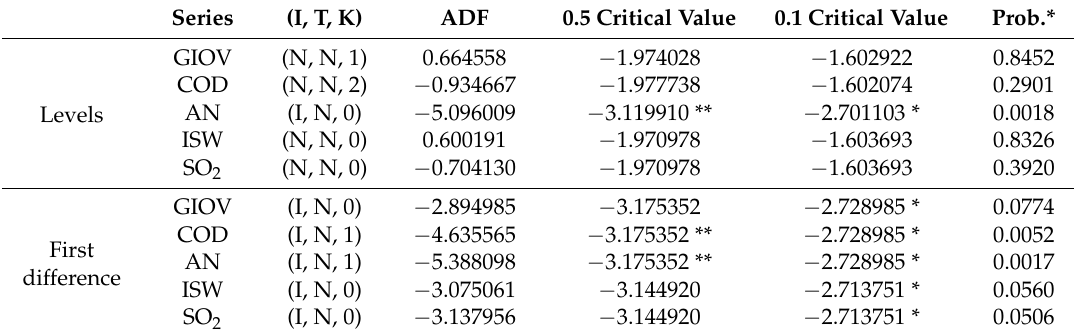
Table 6. Unit root test results for non-metal ore mining and